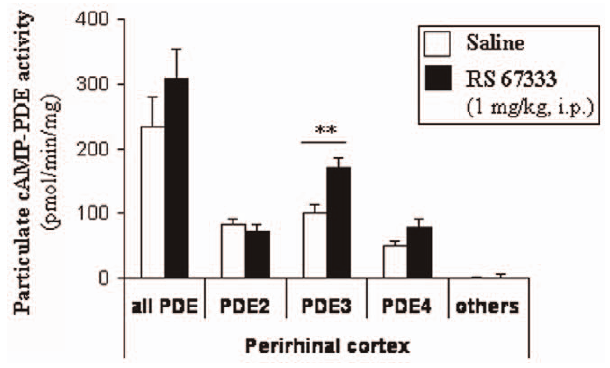
Figure 2. Effect of RS 67333 (1 mg/kg, i.p.) on PDE activities in the perirhinal cortex from rats performing the object recogni- tion task with a 4-h delay. Rats were injected with saline or the 5- HT4 receptor agonist RS 67333 (1 mg/kg, i.p.), 30 minutes before exposure to the sample trial of he object recognition task. Immediately after the testing trial, particulate fractions from the hippocampus, prefrontal and perirhinal cortices were isolated and assayed for EHNA- (20 m M), milrinone- (20 m M) and rolipram- (10 m M) sensitive PDE activities, respective inhibitors of PDE2, PDE3 and PDE4 families. PDE inhibitor-sensitive and –insensitive PDE activities were each expressed as pmolcAMPhydrolysed/min/mg protein. Results are means 6 SEM of four independent subcellular fractionations performed in triplicate. Within each subcellular compartment, * indicates a significant difference of PDE activity as compared with saline treatment within a family of PDE activity (PDE2, 3, 4 or other PDE) (**, P , 0.01, ANOVA followed by Fisher’s LSD